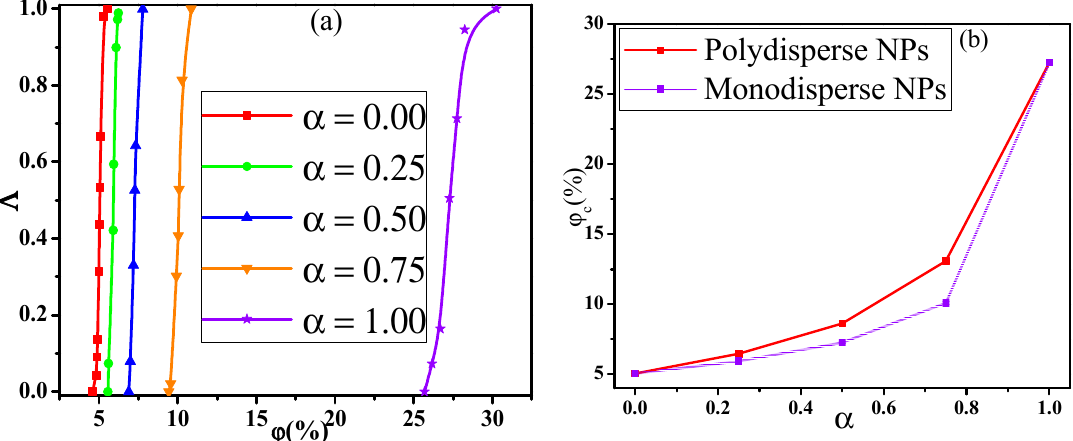
Figure 6. ( a ) Conductive probability Λ with the concentration ϕ of monodisperse nanoparticles and ( b ) their percolation threshold ϕ c in respect of the mixing ratio ( α